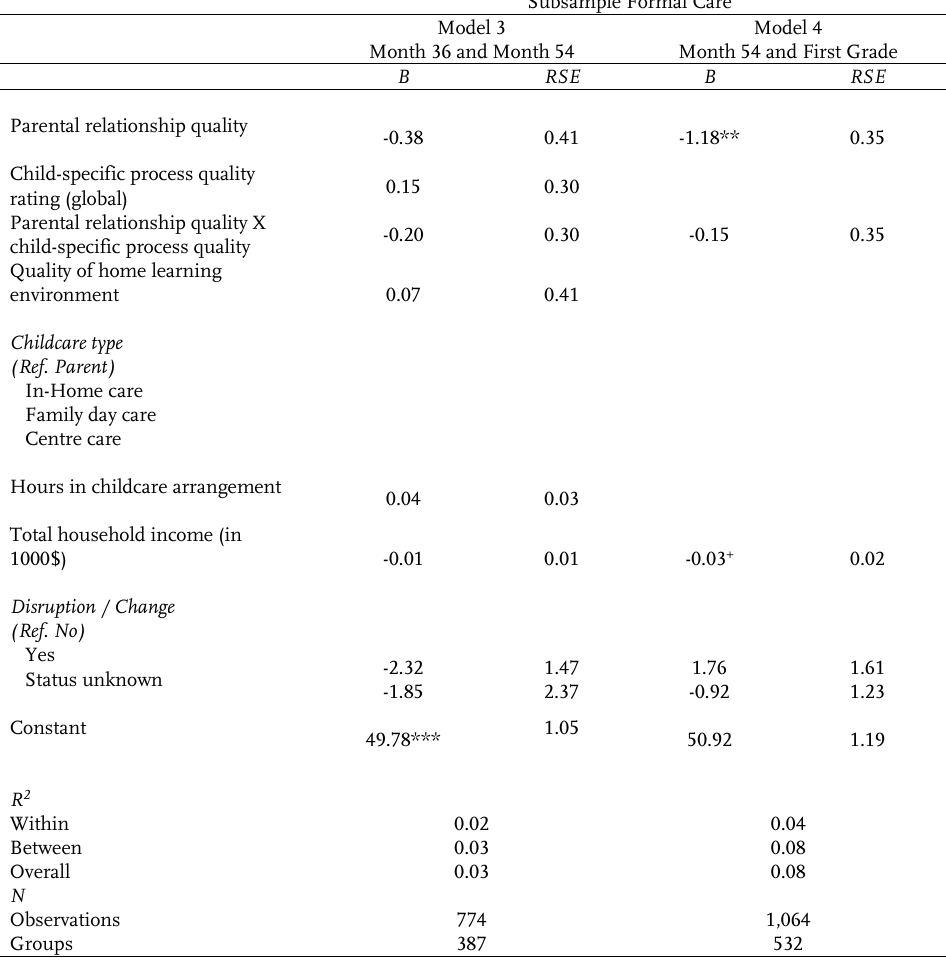
Table 3 : Fixed-effects models of child behavior checklist scores, month 36 through first grade, with child-specific process quality rating (global)